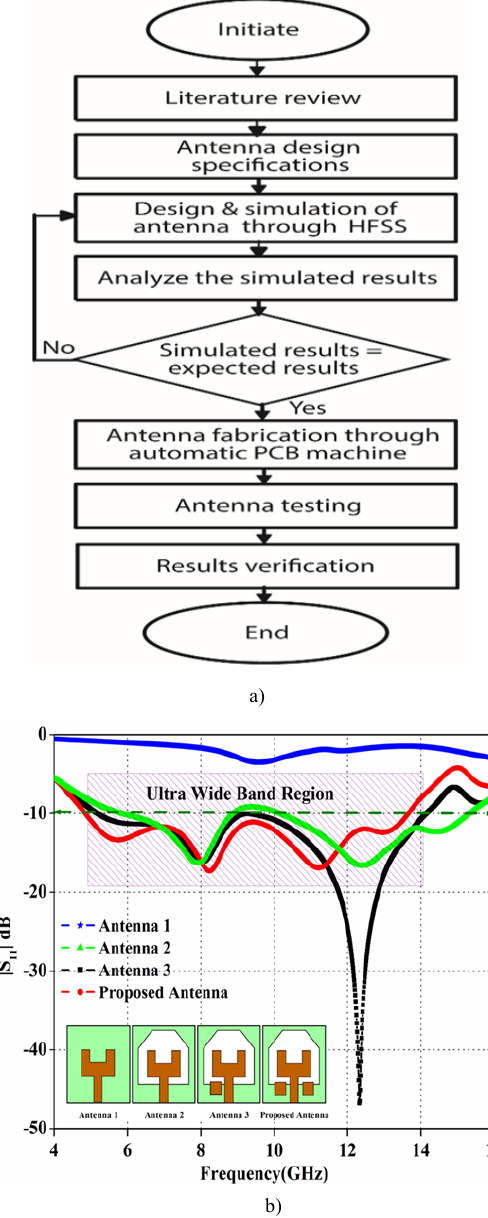
Fig. 2. a) Flow chart of antenna design; b) Stepwise structure growth to analyse the proposed